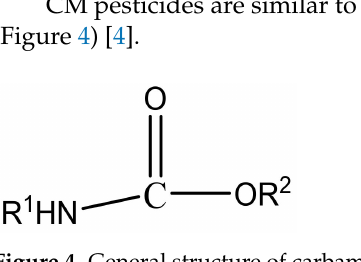
Figure 4. General structure of carbamate pesticides [6,14,24].